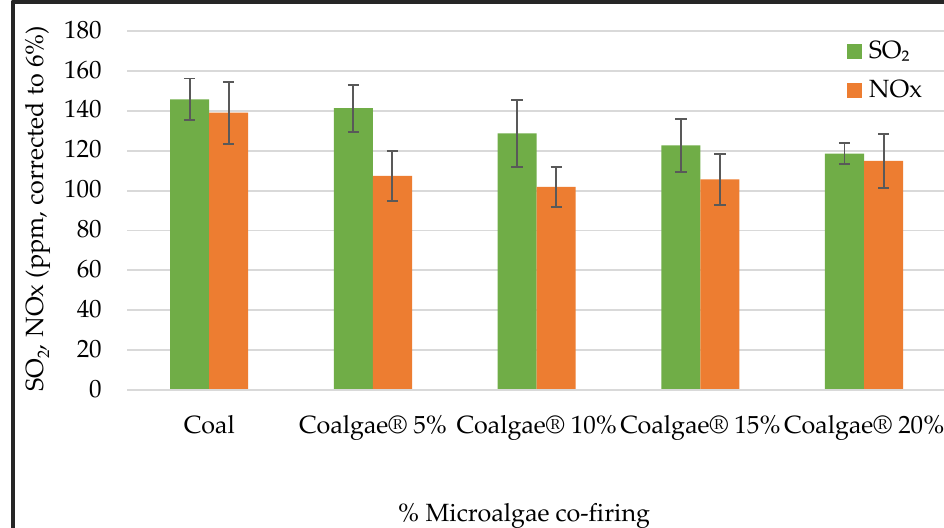
Figure 8. Average concentration of NOx and SO 2 in flue gas.